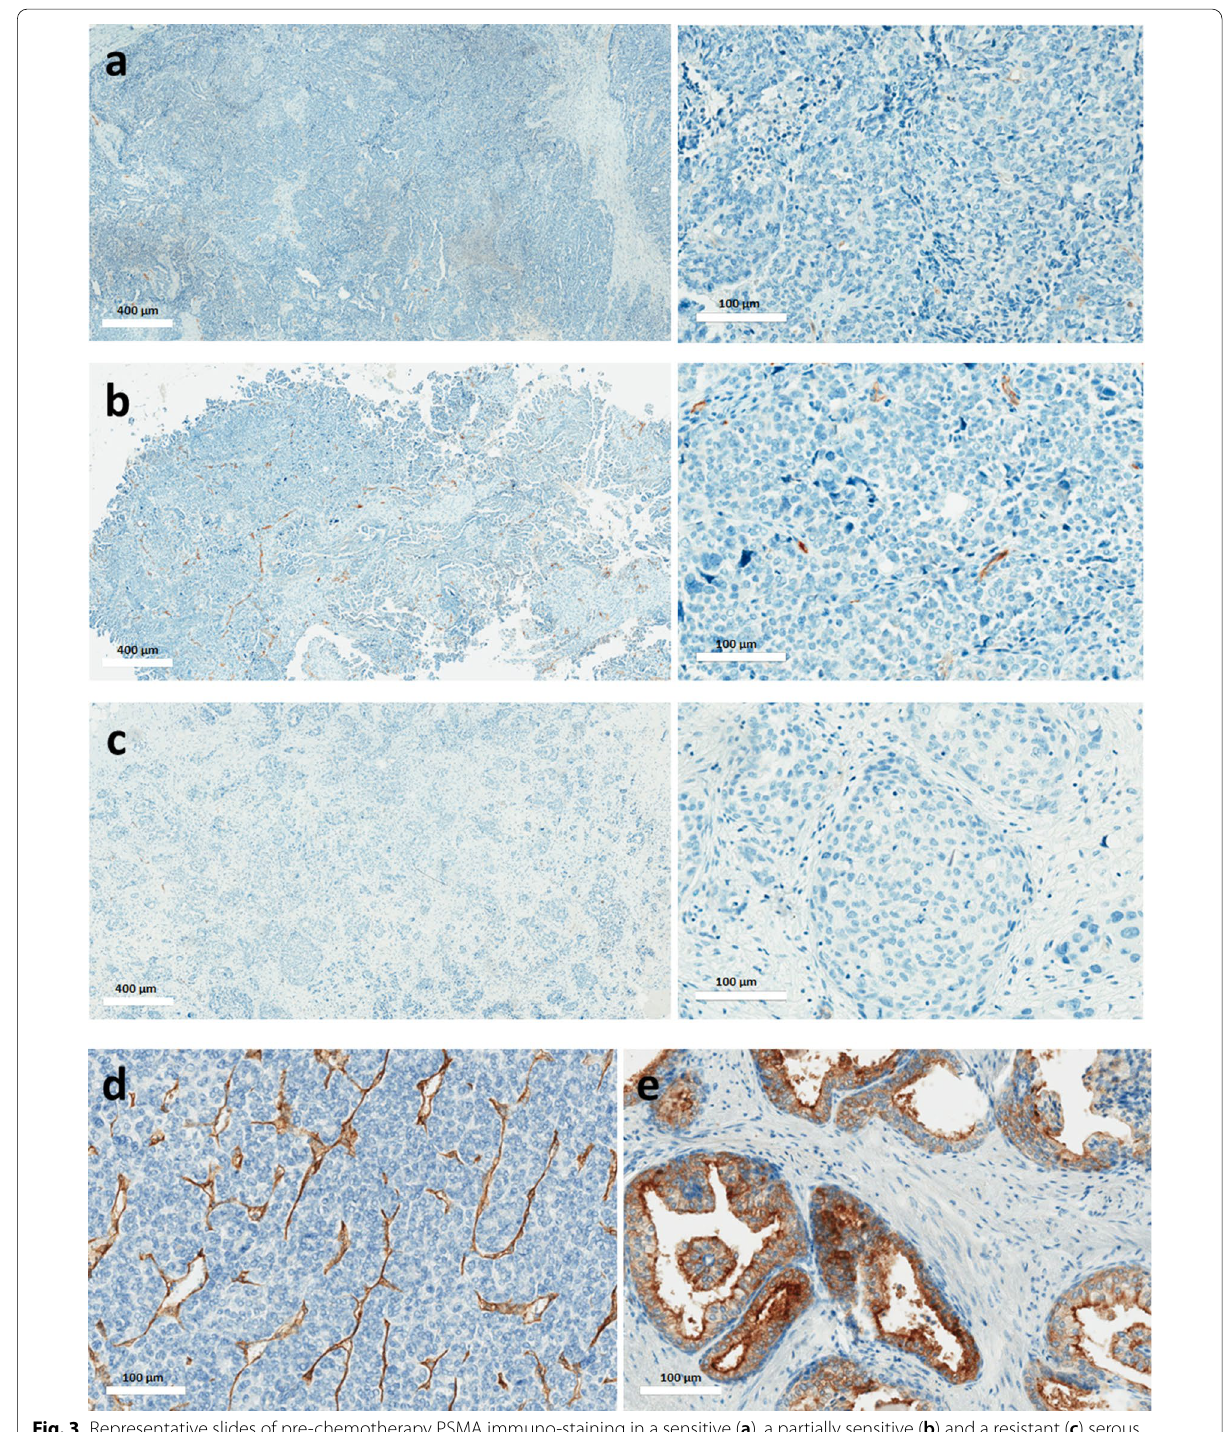
Fig. 3 Representative slides of pre‑chemotherapy PSMA immuno‑staining in a sensitive ( a ), a partially sensitive ( b ) and a resistant ( c ) serous epithelial ovarian cancer. A very partial immuno‑staining of tumour neovascularization can be seen in panel b . Lower panels correspond to positive controls: refractory thyroid cancer ( d ) and normal prostate tissue ( e ). For refractory thyroid cancer ( d ), we observe an immuno‑staining of neovascularization, while for prostate cancer ( e ) there is an immuno‑staining of prostate glandular